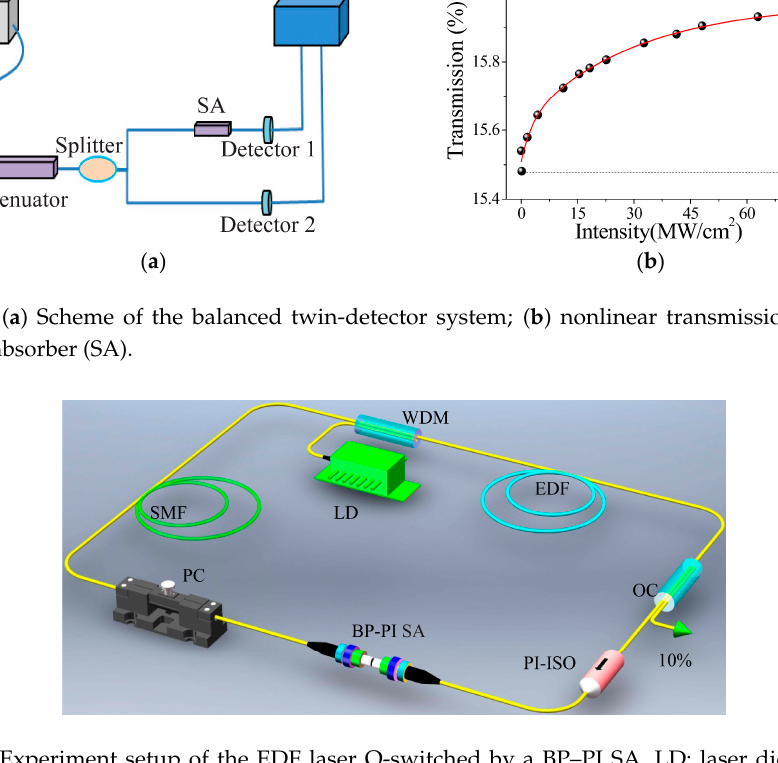
Figure 4. Experiment setup of the EDF laser Q-switched by a BP–PI SA. LD: laser diode; WDM: wavelength division multiplexer; PI-ISO: polarization-independent isolator; EDF: erbium-doped fiber; SMF: single-mode fiber; OC: optical coupler; BP–PI SA: black-phosphorus–polyimide saturable absorber; PC: polarization controller.